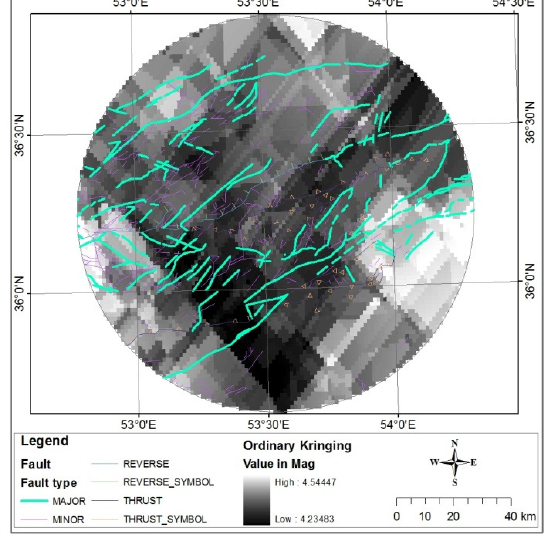
Figure 3: interpolated map of seismic activity by OK method The LPI map also shows a trend that decrease in pixel values, i.e., higher magnitude values in earthquake, just from southeast portions of the area towards the northwest areas (Figure 4).